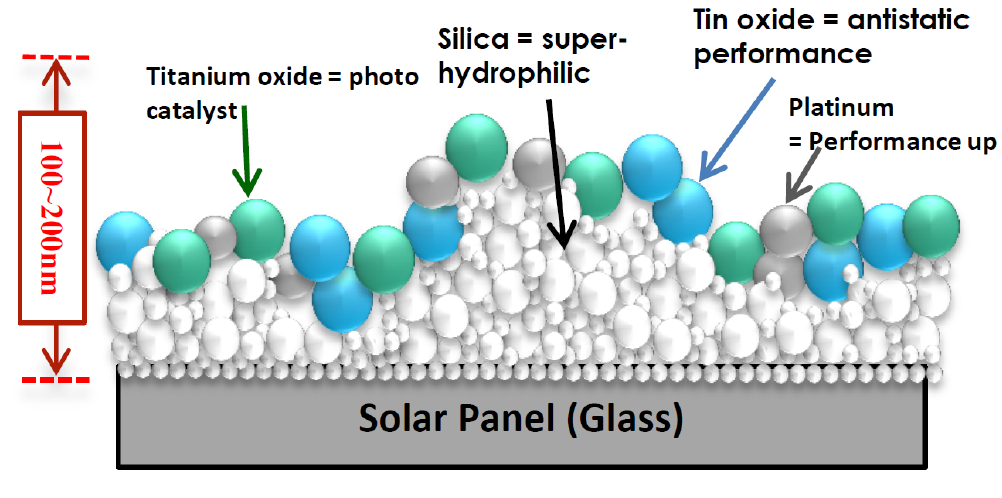
Figure 3. Coating effect on panel